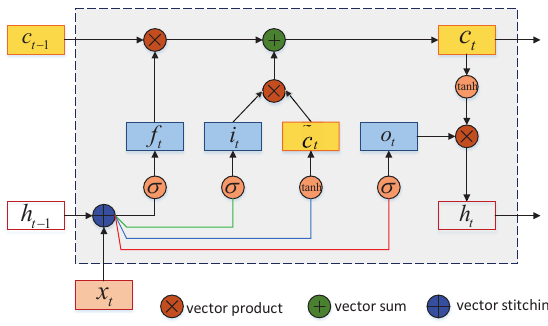
Figure 1. Long short-term memory (LSTM) loop unit